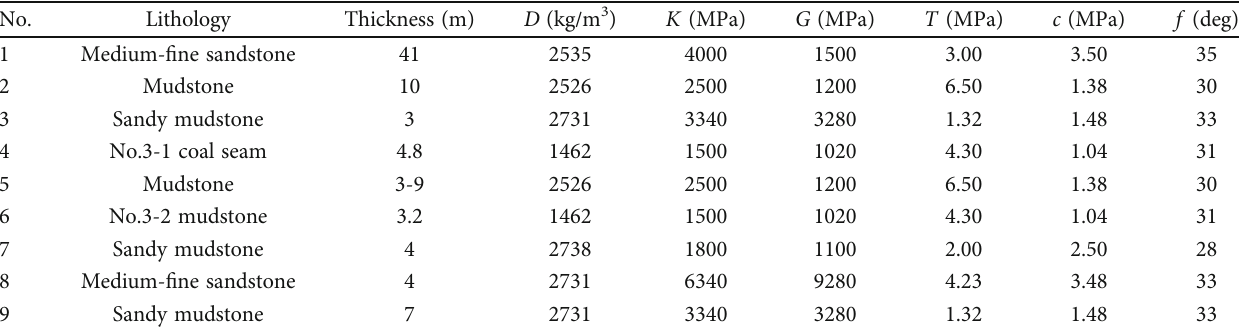
Figure 7: Con fi guration of the model performed using FLAC3D. Table 1: Rock strata properties used in the numerical